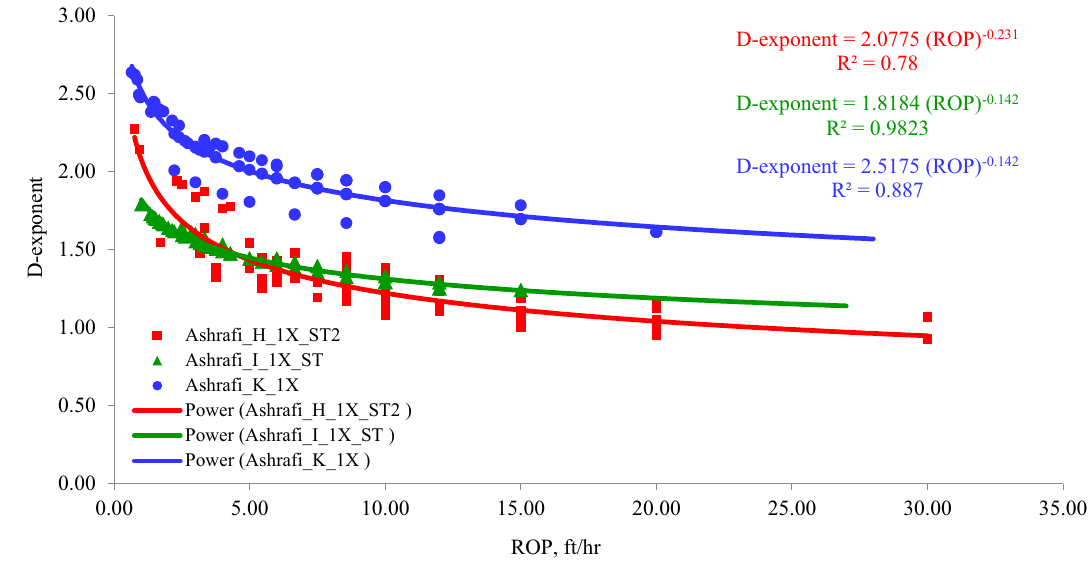
Fig. 4 D -exponent and rate of penetration (ROP, ft/h) relationship for the three studied